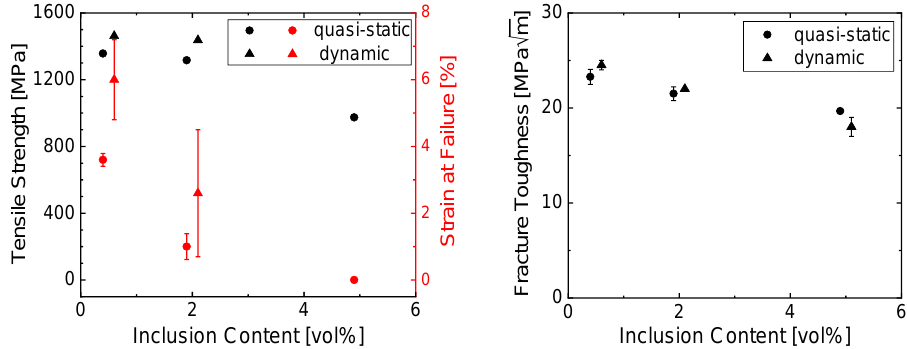
Fig. 3. Results for dynamic tensile tests (left) and Charpy low-blow tests (right). Data points were slightly shifted for better visibility.